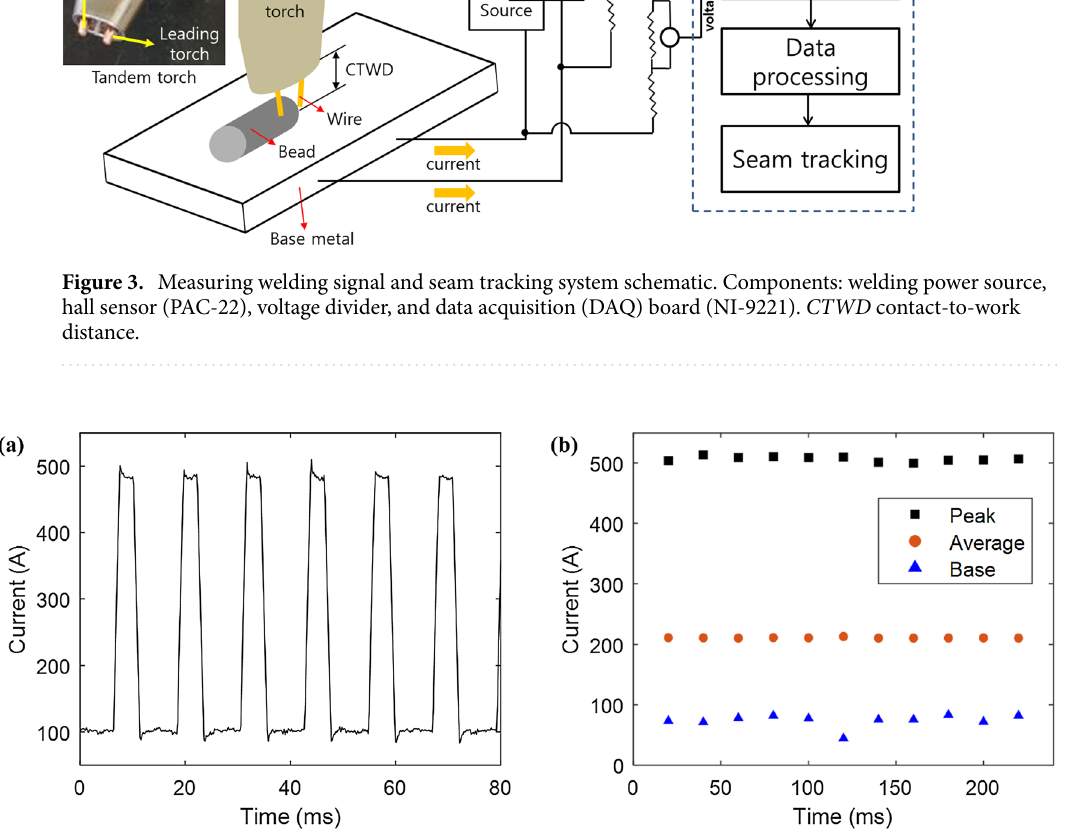
Figure 4. Data separation process. ( a ) Raw data of welding current and ( b ) current data with moving average applied after separating into peak, base, and average (wire feeding speed: 6 m/min, contact-to-work distance: 16